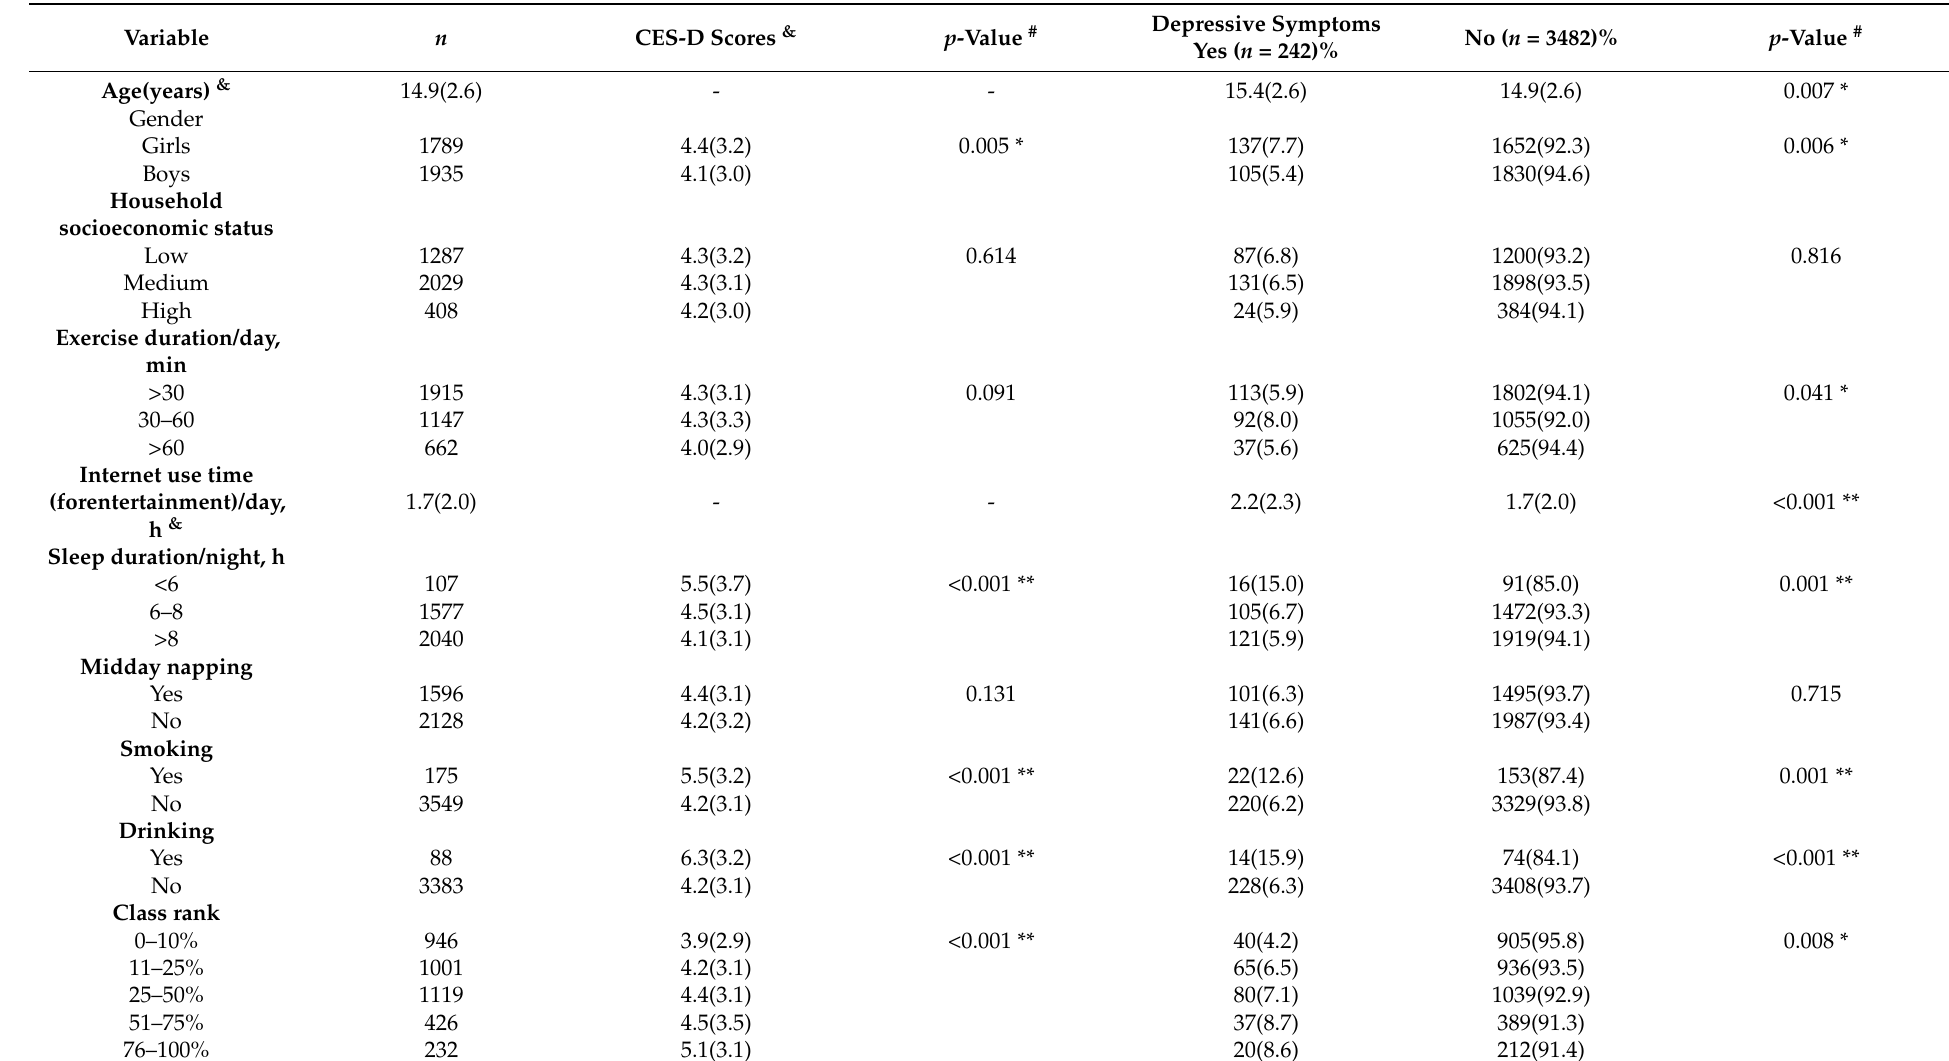
Table 1. Baseline characteristics among 3724